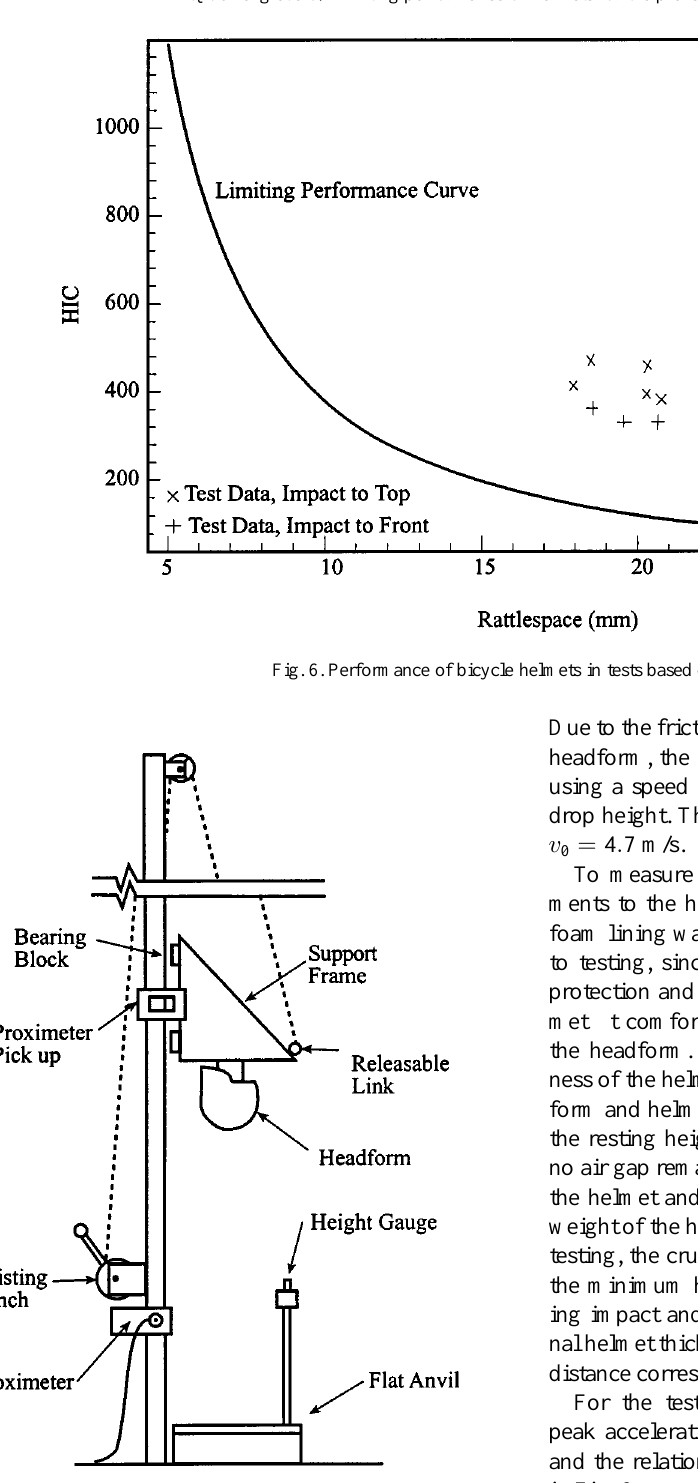
Fig. 7. Primary components of the head-drop